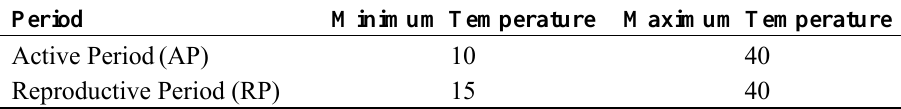
Table 2. Threshold temperatures (°C) of P. papatasi Physiologic